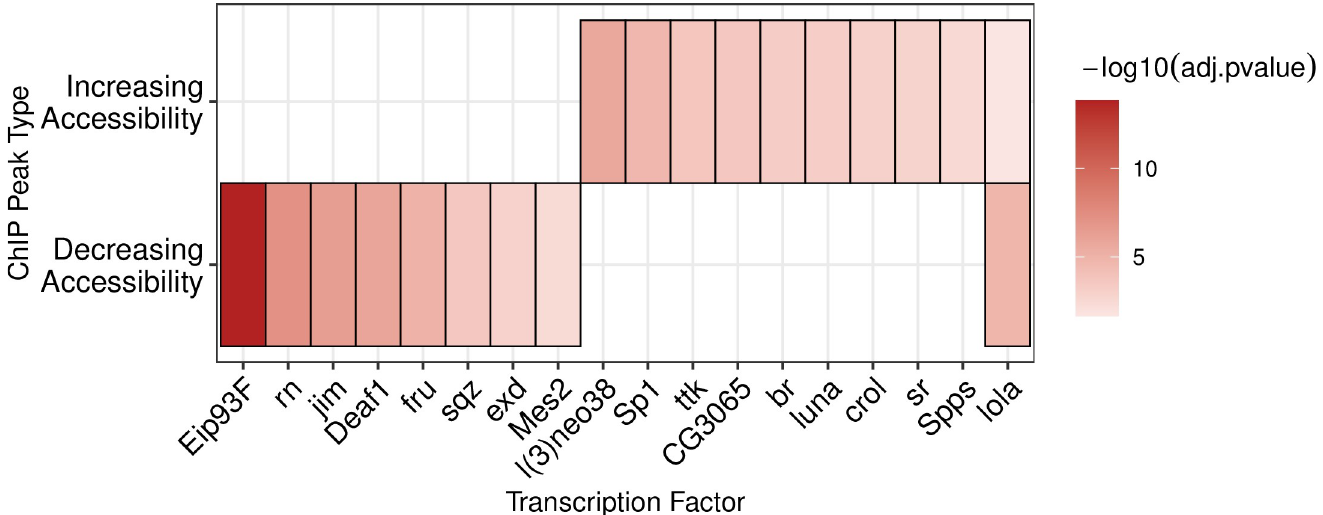
Fig 3. A heatmap of the -log10(adj.pvalues) from AME enrichment testing within increasing and decreasing sites.